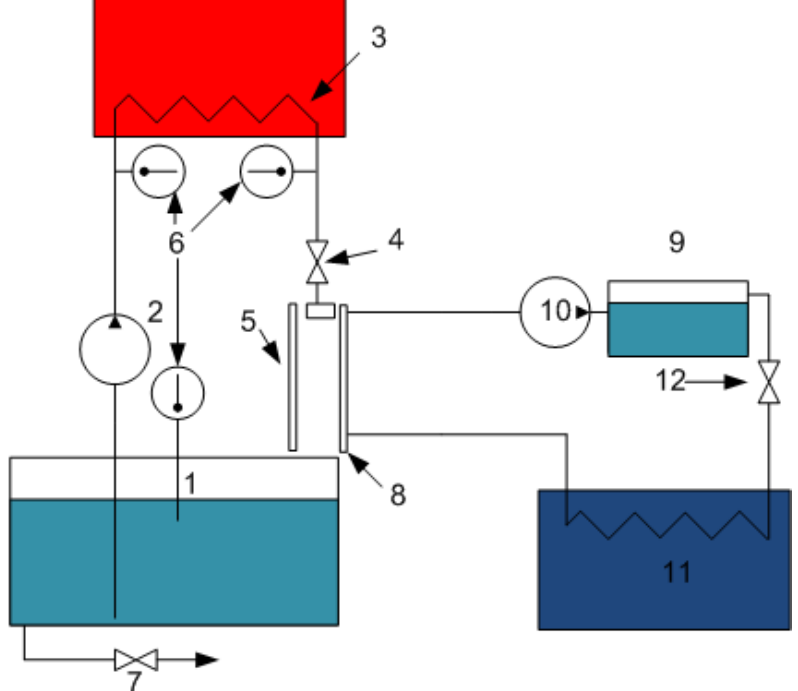
Figure 4. FD-PC installation diagram. 1 — tank with treated liquid (seawater), 2 — pump, 3 — coil, 4 — control tap, 5 — evaporating surface, 6 — thermometers, 7 — drain tap, 8 — porous condenser, 9 — container with distilled water, 10 — pump, 11 — chiller, 12 — control tap.